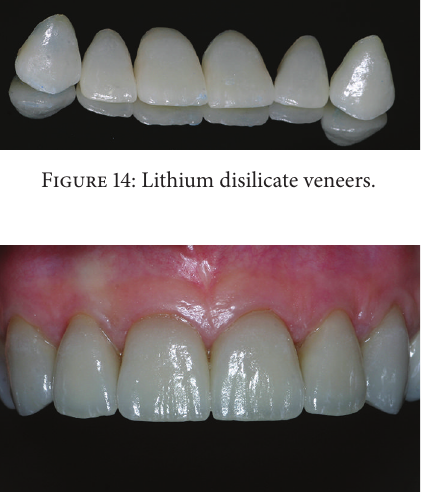
Figure 15: Veneers luting.